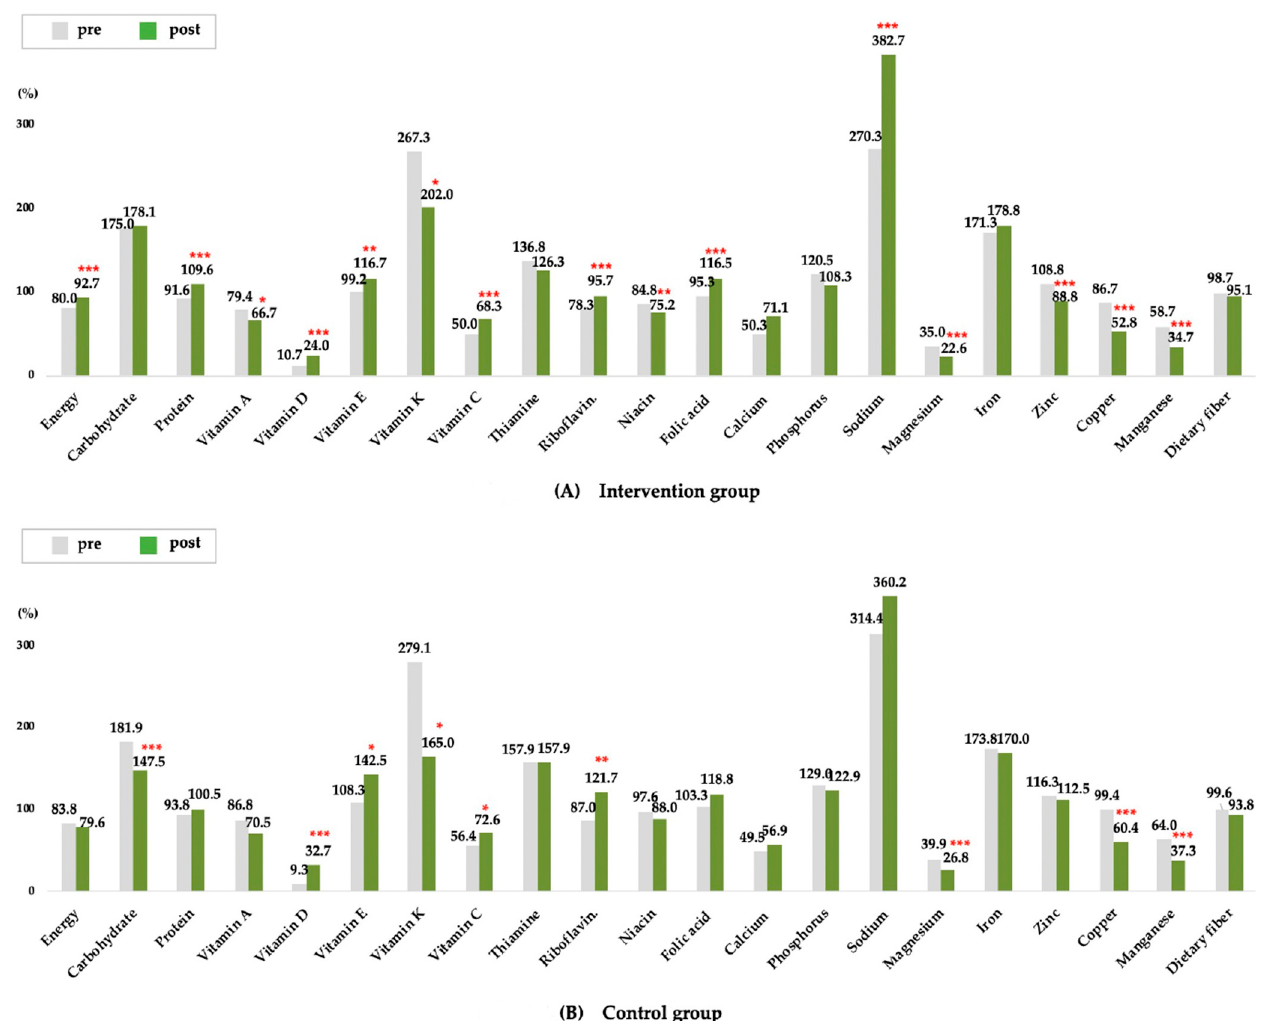
Figure 1. The ratio of intake to the appropriate nutrient standard for each group. Data are reported as dietary reference intakes versus actual intake (%) for the elderly in Korea. Asterisks indicate significant differences pre-post results (* p < 0.05, ** p < 0.01, and *** p < Table 3. Changes of functional capacity and clinical features for each group.